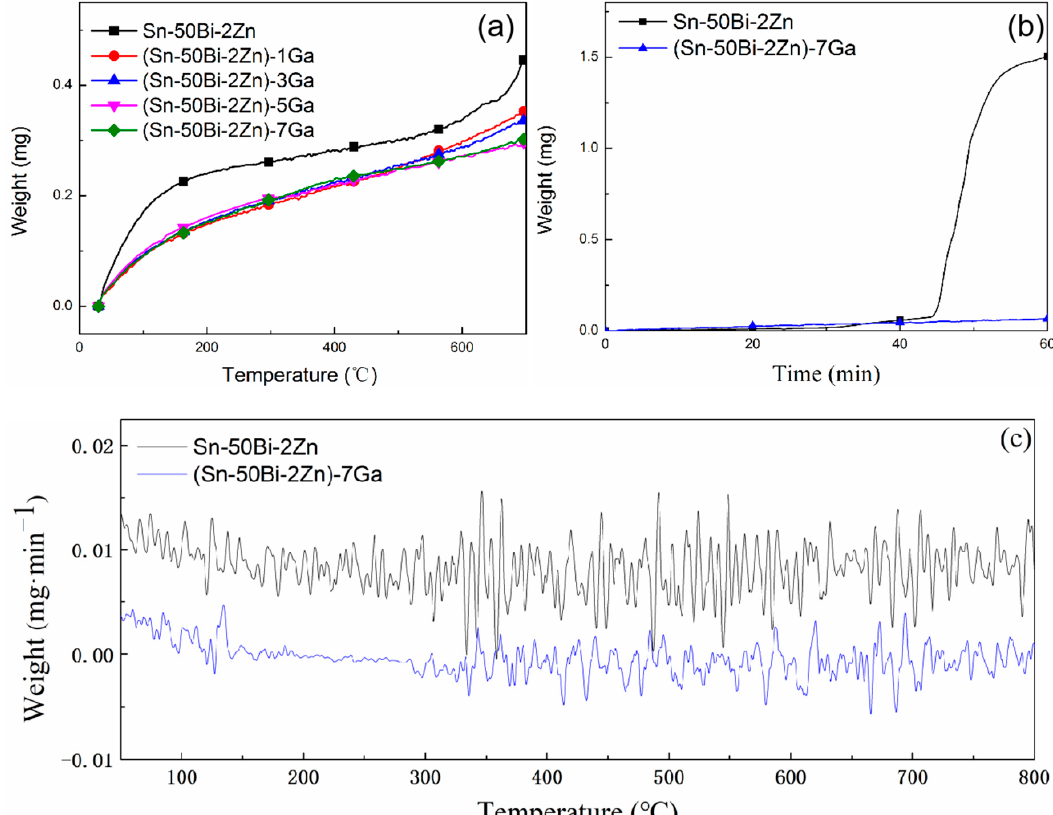
Figure 1. TG curves of the test alloys. ( a ) Weight gain curves with temperature, ( b ) weight gain curves with time, and ( c ) weight gain per minute with